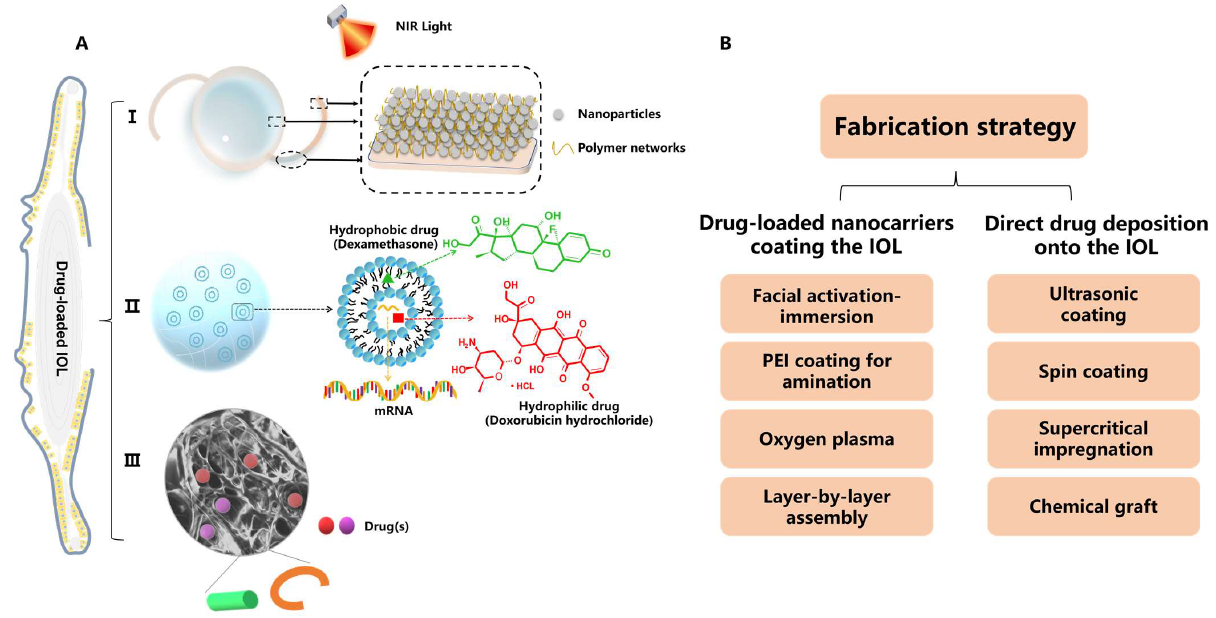
Figure 2. ( A ) Illustration of DDSs employing nanotechnology for PCO prevention, including I. drug- loaded IOL, II. NPs and their hydrogel composite and III. implants such as capsular tension ring and solid pellet/inserts. Inset: an example of polymeric nanostructure carrying pharmacological agent(s). ( B ) Fabrication strategies of drug-loaded IOLs for PCO therapy.